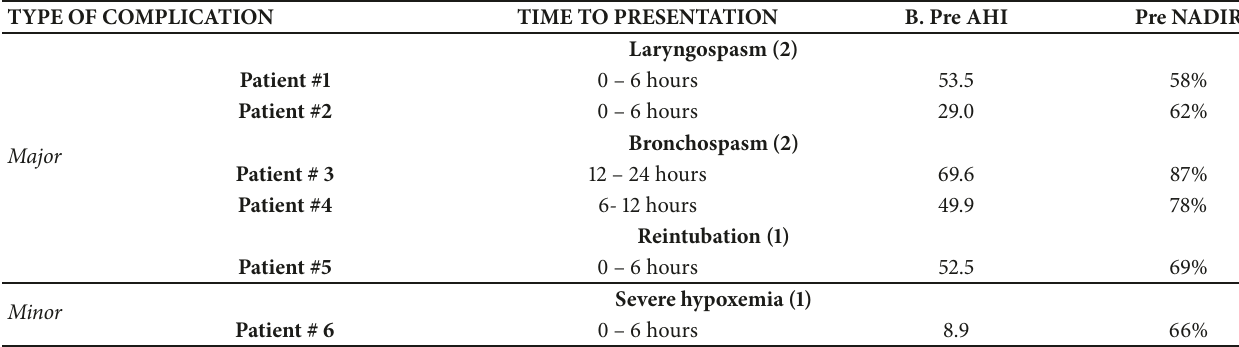
Table 3: A. Time to presentation of respiratory complication in the initial 24 hours after surgery; B. preoperative AHI and Nadir values in the complicated